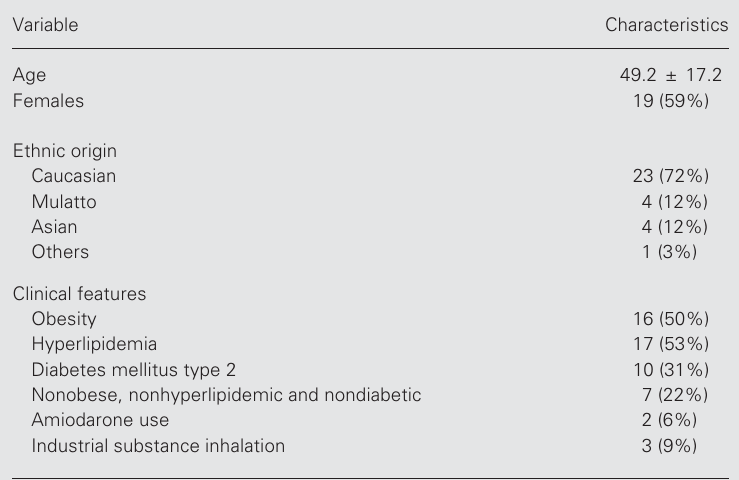
Table 1. Clinical and demographic characteristics of the 32 patients in the present